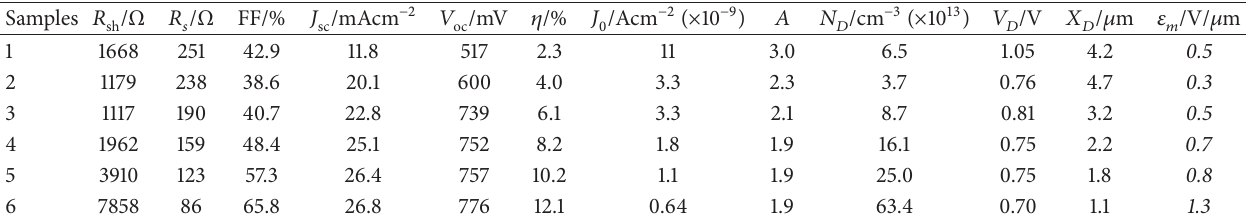
Table 1: Summarized relevant parameters for CdTe